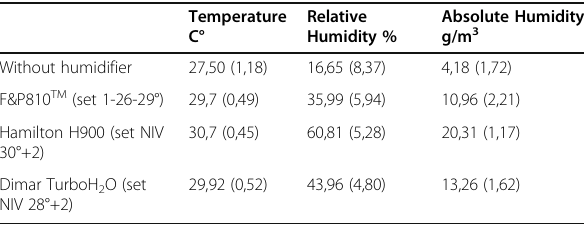
Table 1 (abstract A196). Helmet CPAP